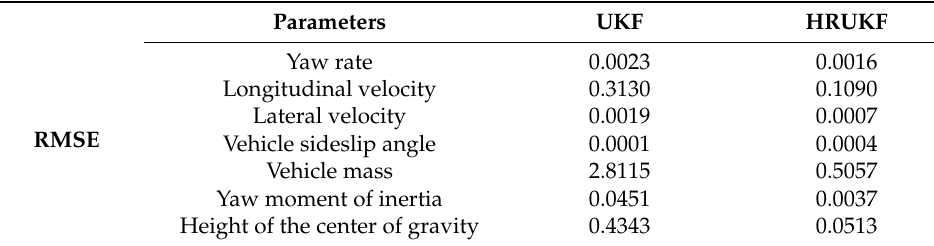
Table 3. RMSE index for straight-line driving condition at constant speed.